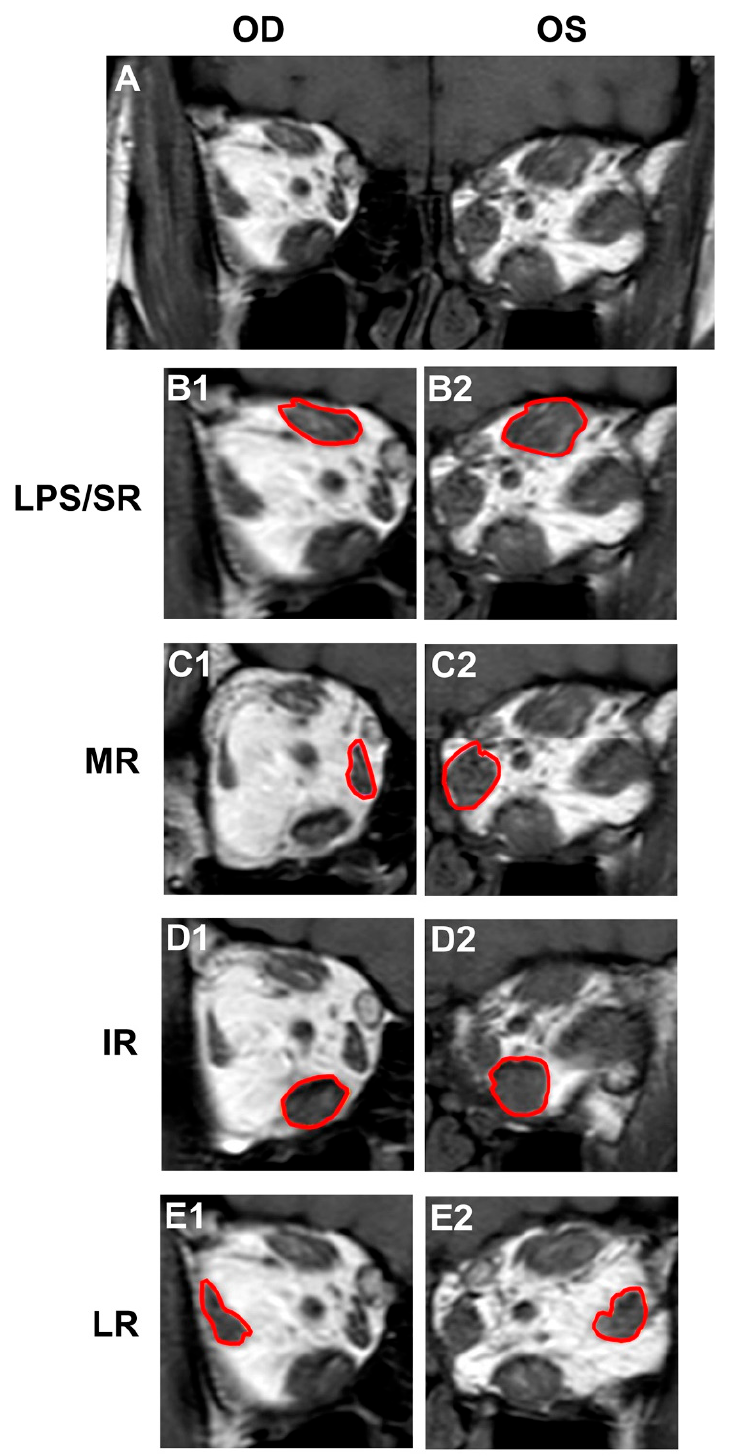
Figure 2. The measurement of the largest cross-sectional area of the extraocular muscle on T1- weighted MR images. ( A ). Representative T1W orbital MR image. ( B1 , B2 ). Segmentation of the largest LPS/SR image. ( C1 , C2 ). Segmentation of the largest medial rectus (MR) image. ( D1 , D2 ). Segmentation of the largest lateral rectus (LR) image. ( E1 , E2 ). Segmentation of the largest inferior rectus (IR) image. Red line represents segmentation of extraocular muscles. LPS/SR, levator palpebrae superioris–superior rectus complex.